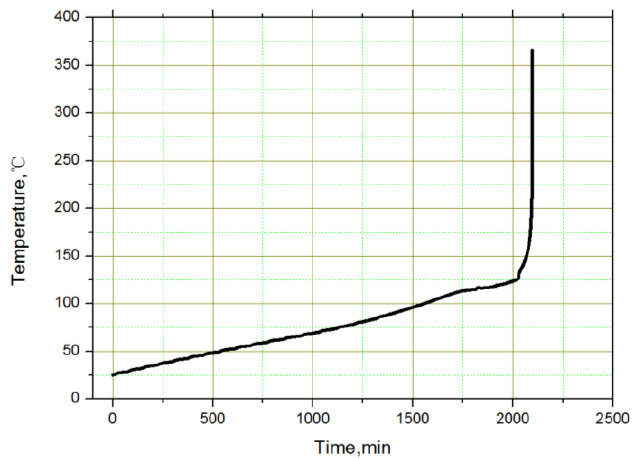
Figure 9. The thermal load of the overheated battery in the middle of the